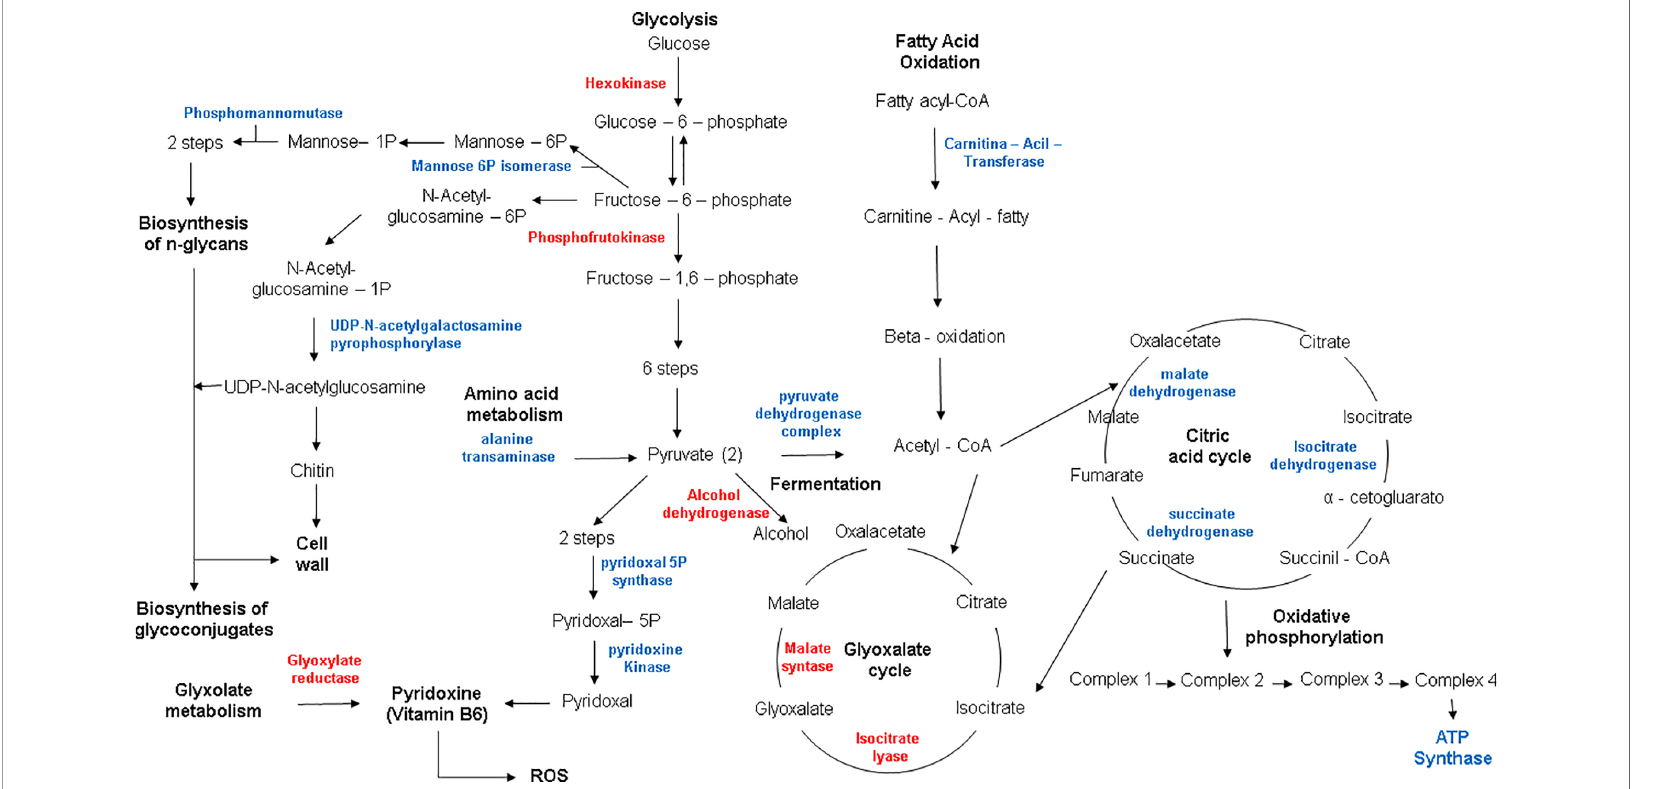
FIGURE 5 | Metabolic pro fi le of H. capsulatum yeasts during zinc deprivation. Red: downregulated proteins; Blue: upregulated